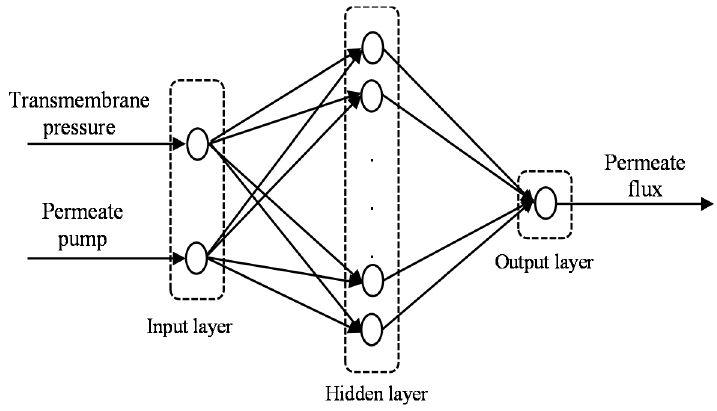
Figure 3. Schematic structure for